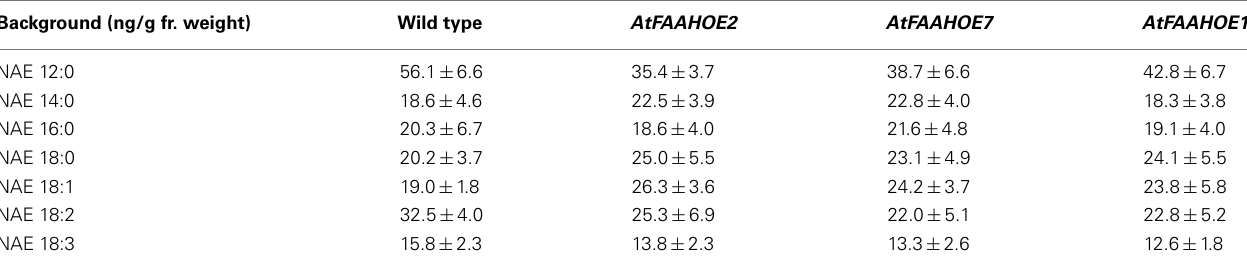
Table 2 | N -acylethanolamines profiles of 14-day-old Arabidopsis seedlings grown under short days. Background (ng/g fr.